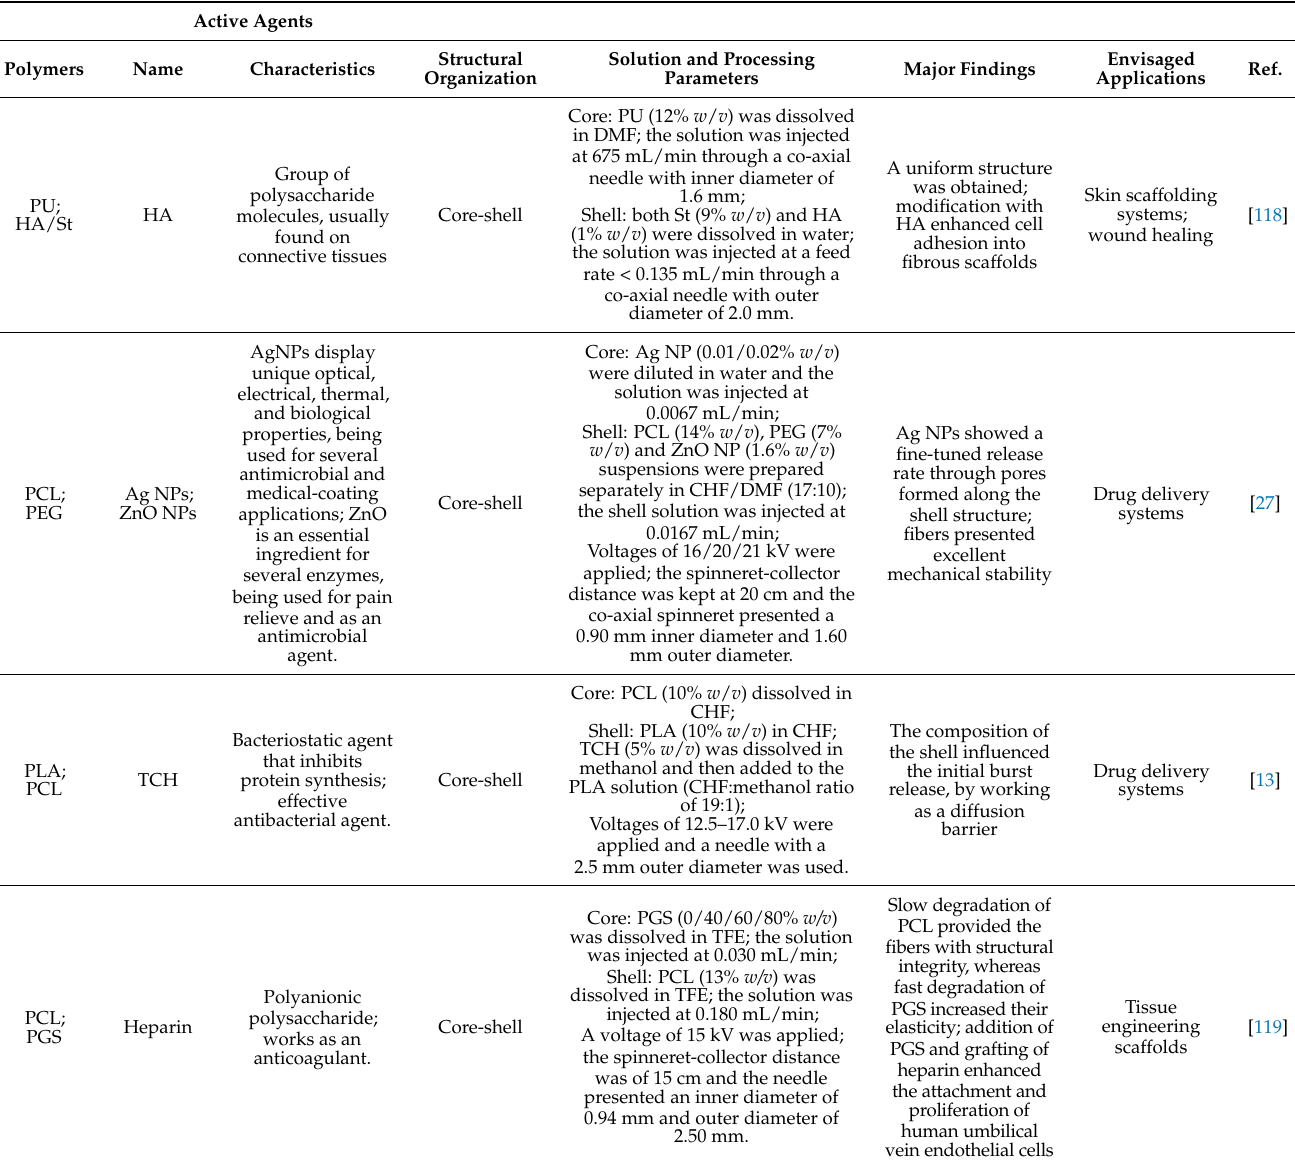
Table 1. Main applications of electrospun fibers with various structural organizations and respective solution/processing